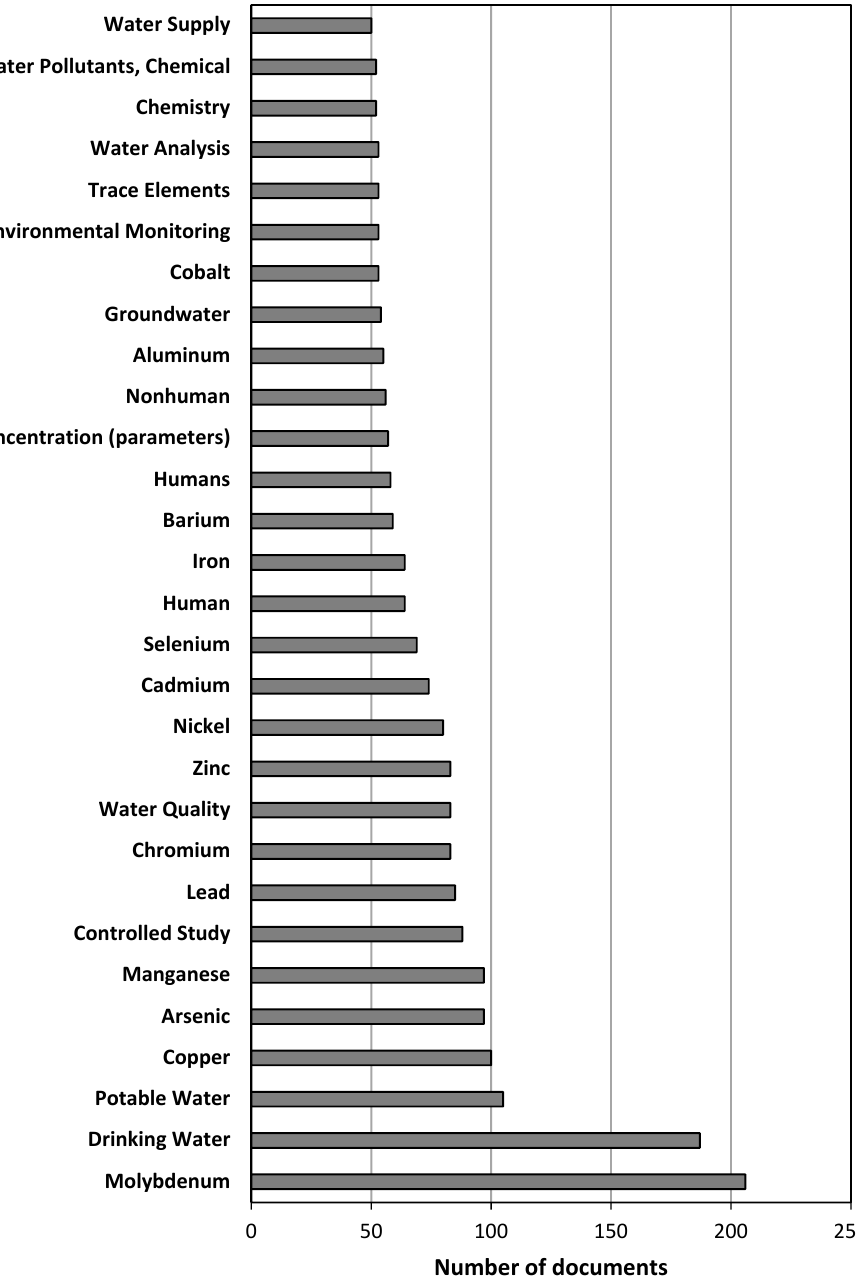
Figure 2. The top 29 most frequently used keywords (at least 50 times).